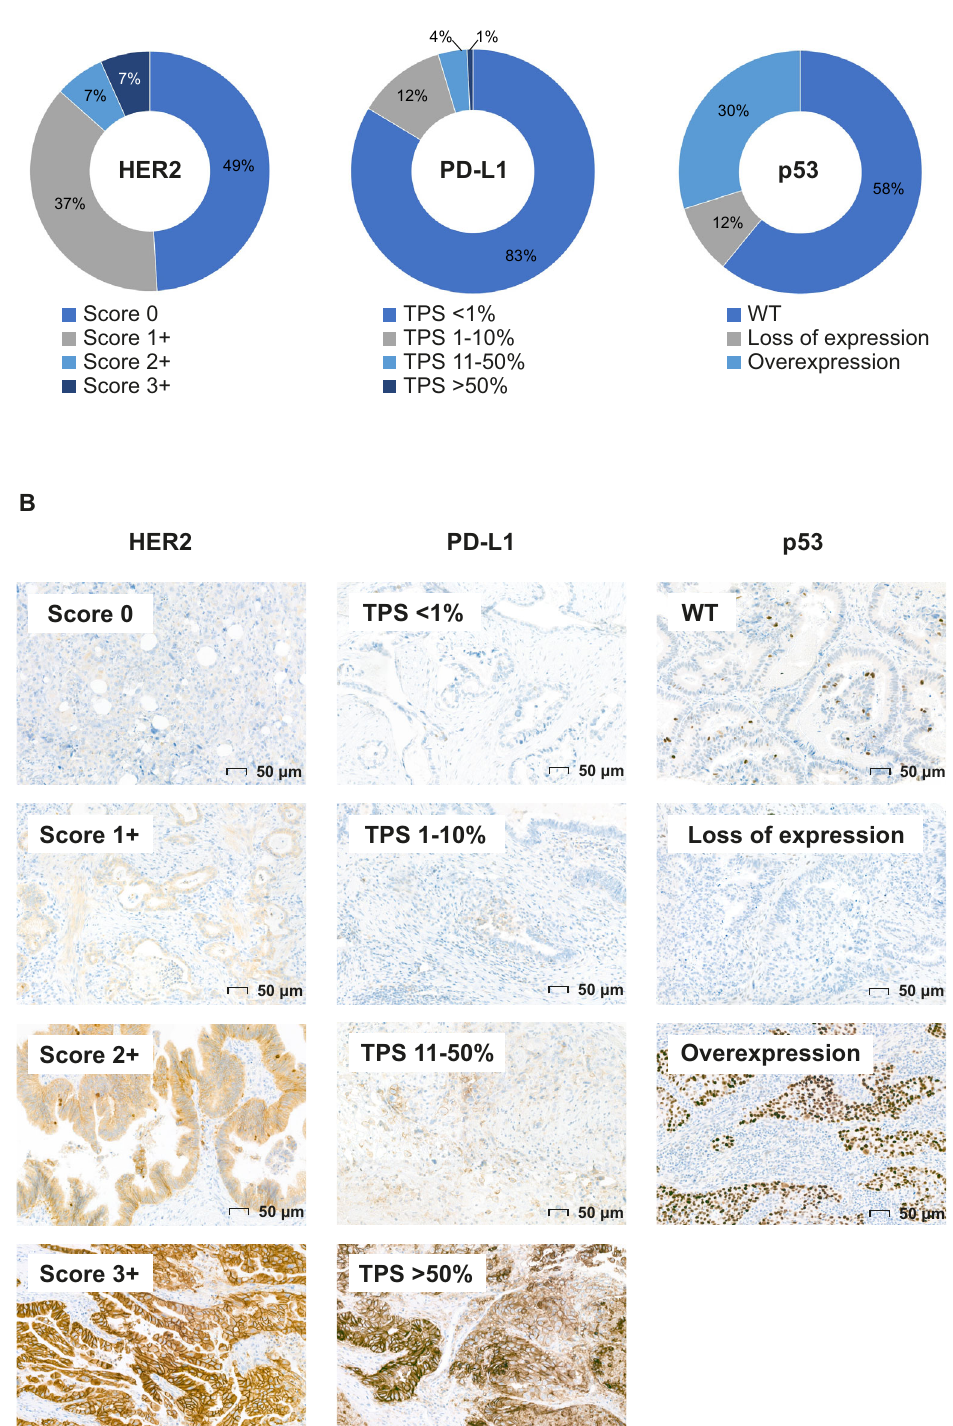
Fig. 4 Potential therapeutic targets on the protein level in GBC ( N = 637). A Distribution of immunohistochemistry (IHC) results. B Representative images of IHC scoring. TPS tumor proportion score. FGFR3-TACC3 fusion in a case with neuroendocrine GBC 21 , but outside this example fusion genes appear not to play a major role in GBC.